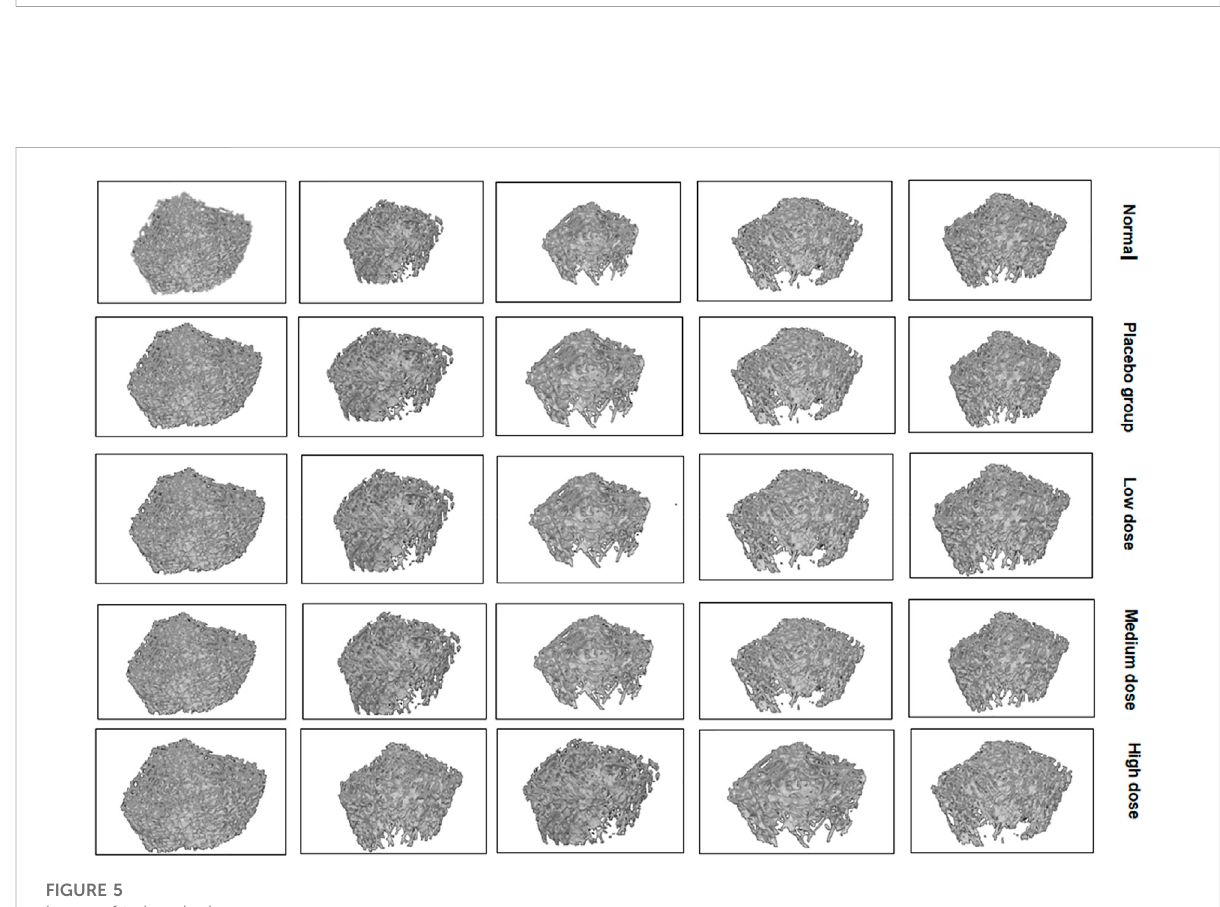
FIGURE 5 Image of trabecular